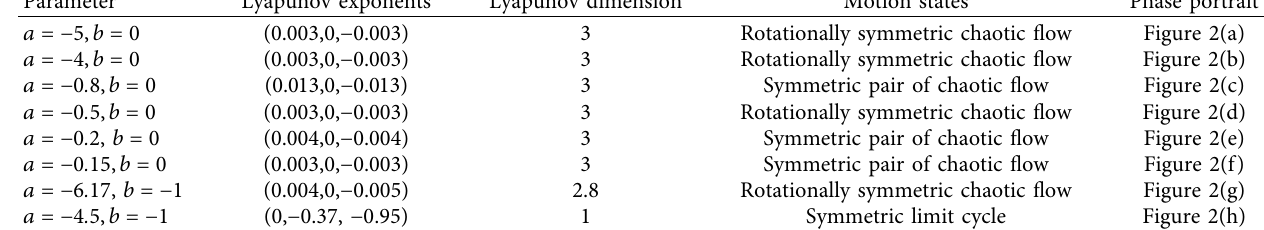
Table 1: Motion states of system (1) for different values of the parameters a,b under c � 1 with initial value ( 0 , 5 , 0 ) . Parameter